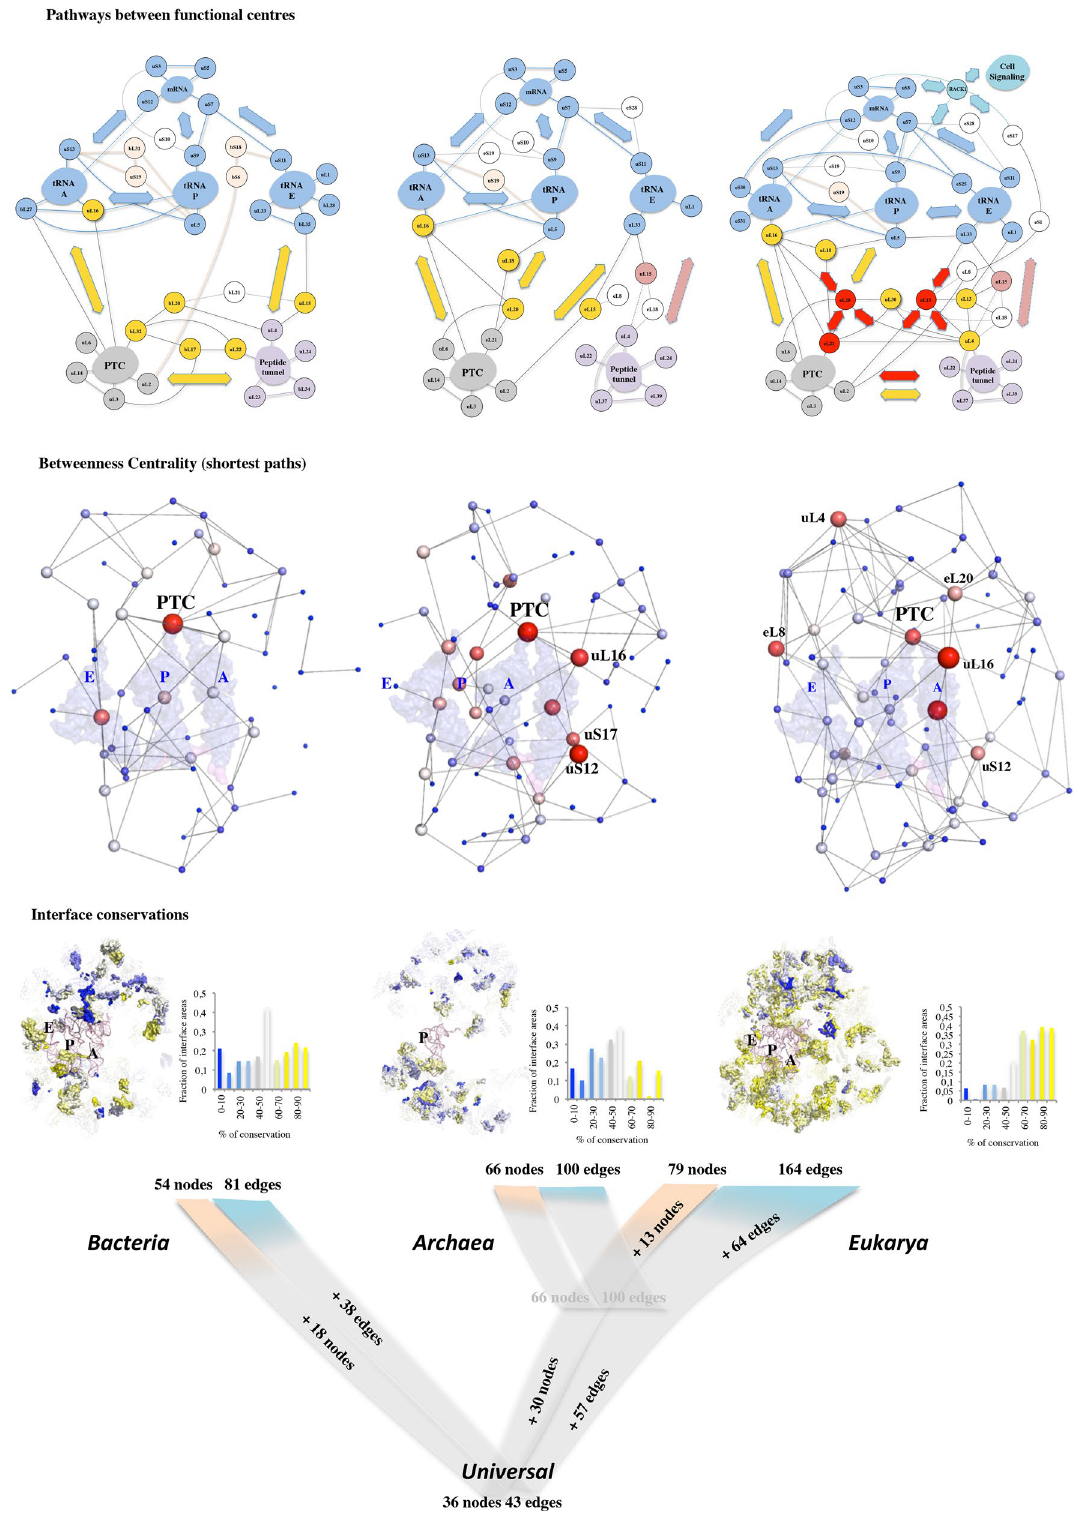
Figure 4. Congruence of evolutionary traits in network expansions. The three kingdoms’ networks are represented according to (from top to bottom) their functional, mathematical and phylogenetic properties. The colour codes corresponding to the functional status of the nodes is the same as in Fig. 3. The graphs are represented by connected spheres whose radius and colour gradient (white > red) are proportional to the betweenness centrality values. Largest red sphere correspond to maxima of betweenness centrality. The three tRNAs A, P and E and the mRNA are represented by transparent surfaces. The mapping of the interfaces and the distribution of the conserved surfaces are represented by a colour gradient from blue (0 conservation) to yellow (100%